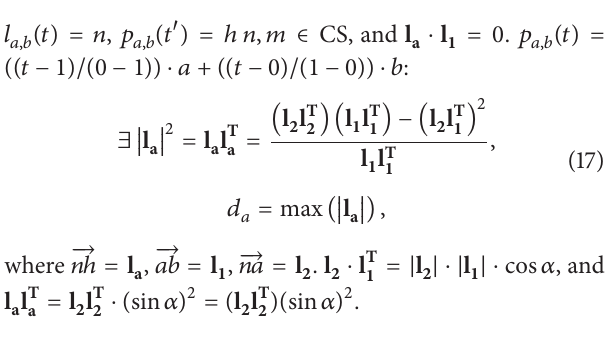
Figure 9: Joints angular optimal displacement (simulation 3).